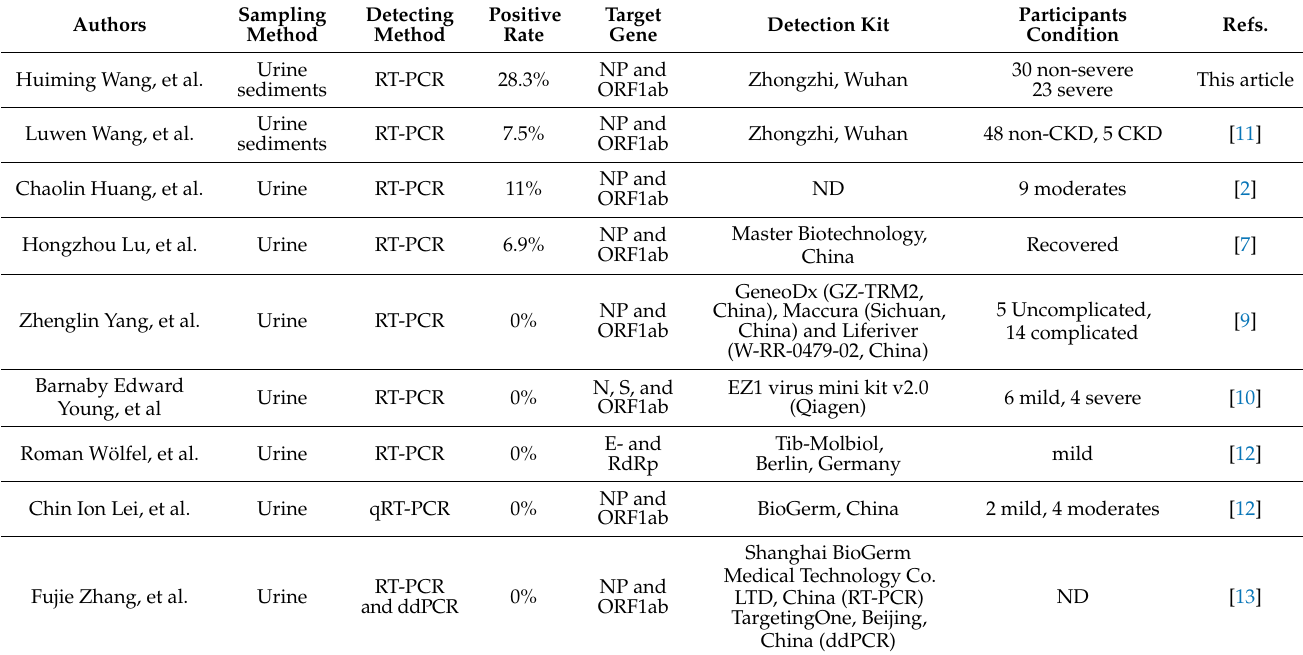
Table 4. Comparison of urinary SARS-CoV-2 nucleic acid detection in literature